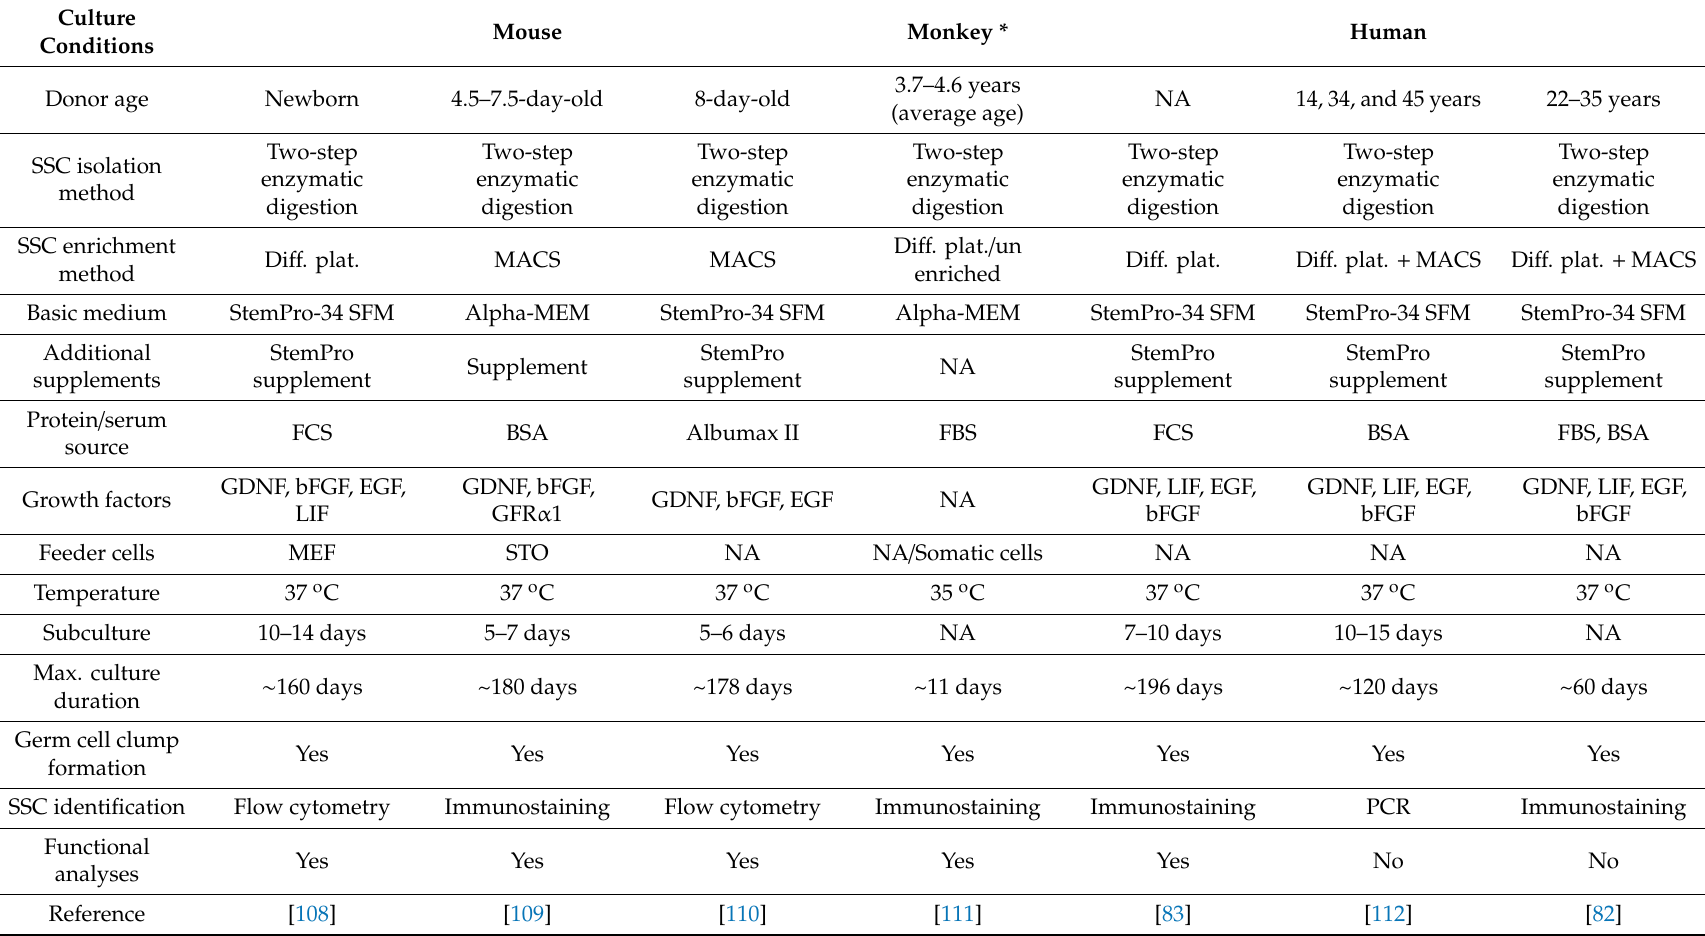
Table 2. Culture conditions for long-term in vitro maintenance of rodent or primate spermatogonial stem cells